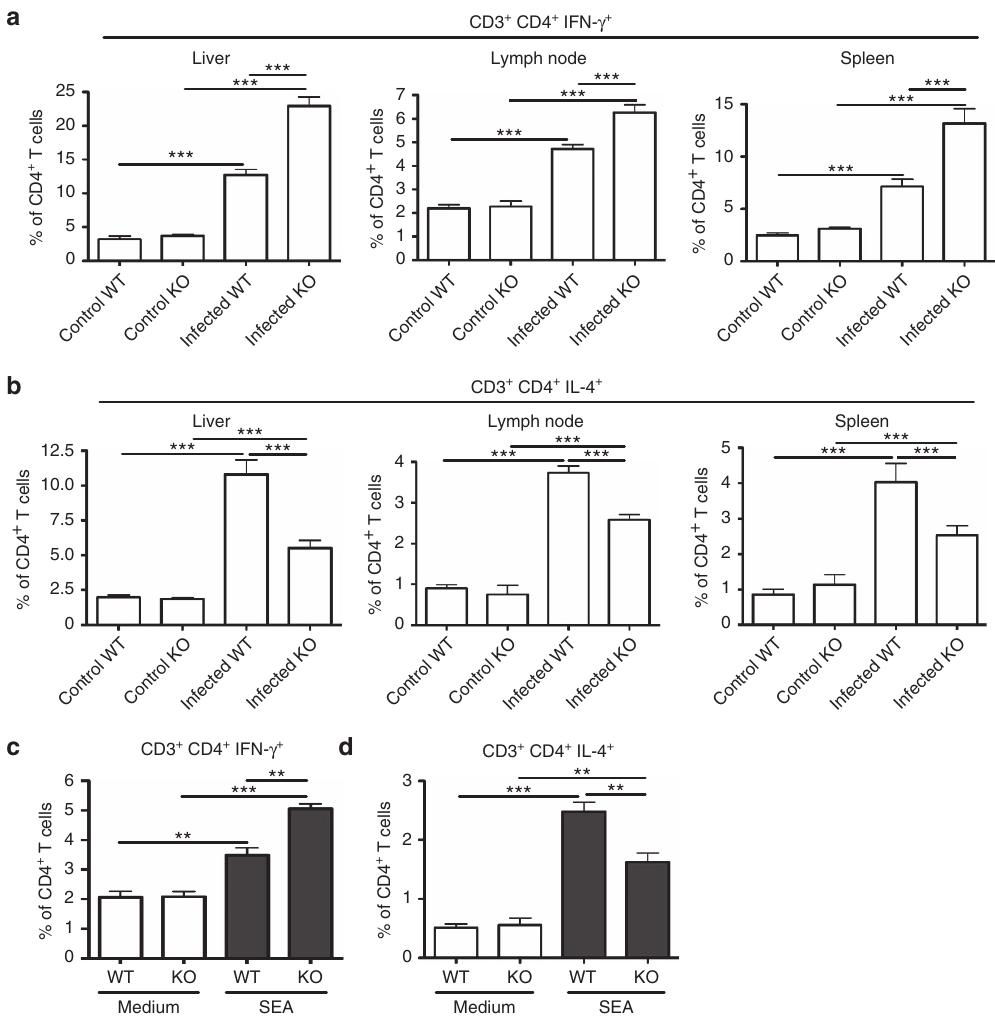
Figure 2 | SR-A deficiency promotes Th1 response after S. japonicum infection. Single-cell suspensions of mouse livers, mesenteric LN and spleens from WT and SR-A-deficient mice infected with or without S. japonicum were prepared. Cells were stained with CD3-APC, CD4-FITC and then intracellularly stained with PE-conjugated antibodies against IFN- g or IL-4 for FACS analysis of CD3 þ CD4 þ IFN- g þ (Th1) ( a ) or CD3 þ CD4 þ IL-4 þ (Th2) ( b ) cells, respectively. Data shown are gated on CD3 þ CD4 þ cells. Data are expressed as the mean ± s.d. of 12 mice for each group from one experiment representative of three independent experiments. Splenocytes from WTor SR-A-deficient mice stimulated with or without SEA, and the proportion of Th1 ( c ) or Th2 ( d ) cells in CD4 þ T cells was analysed by FACS. Data are expressed as the mean ± s.d. from three independent experiments, *** P o 0.001, ** P o 0.01, * P o 0.05